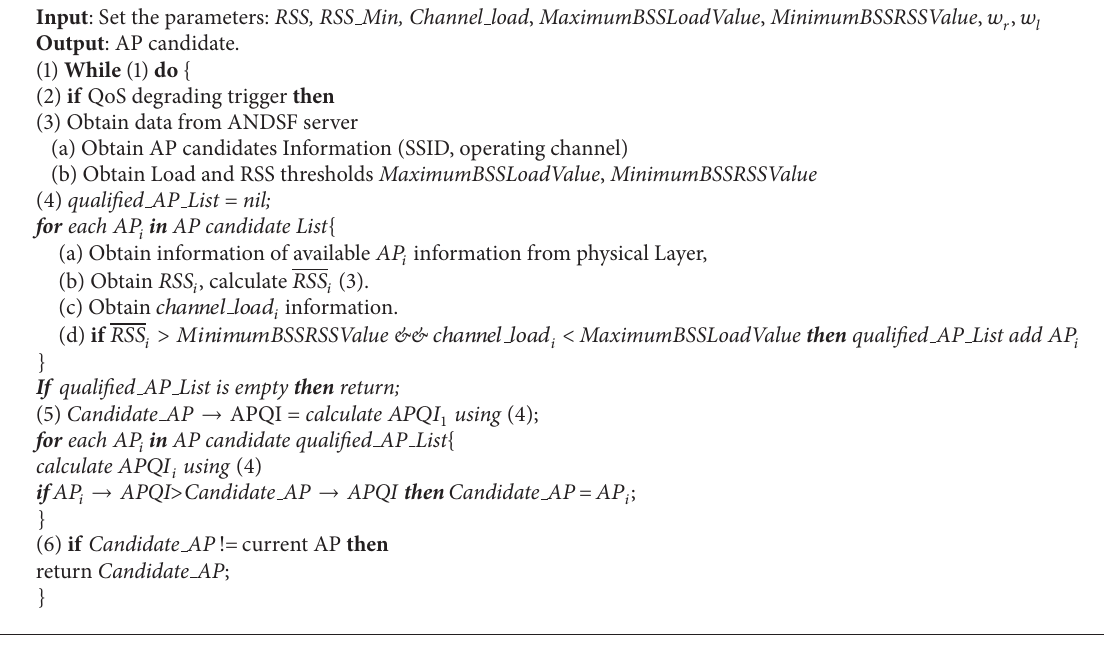
Algorithm 1: Roaming decision and preferable AP selection.